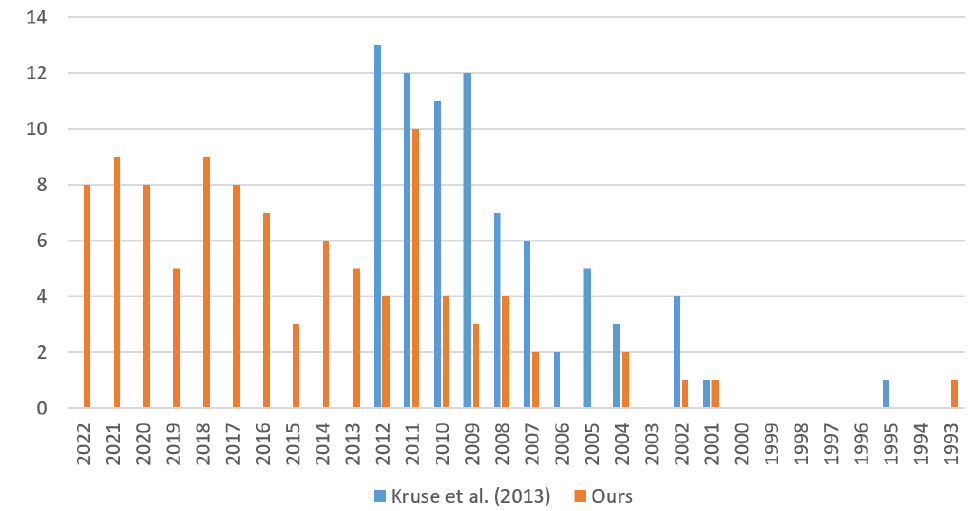
Figure 4. Distribution of publications over years considered by the review paper by Kruse et al. [13] and the current